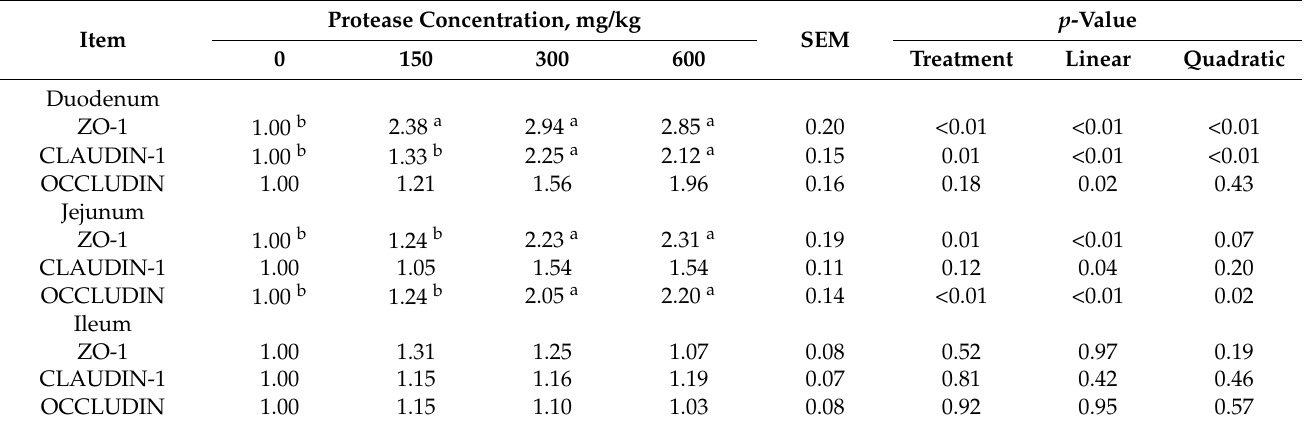
Table 11. Effects of protease supplementation on mRNA expression levels of tight junction proteins in intestinal mucosa of weaned piglets.